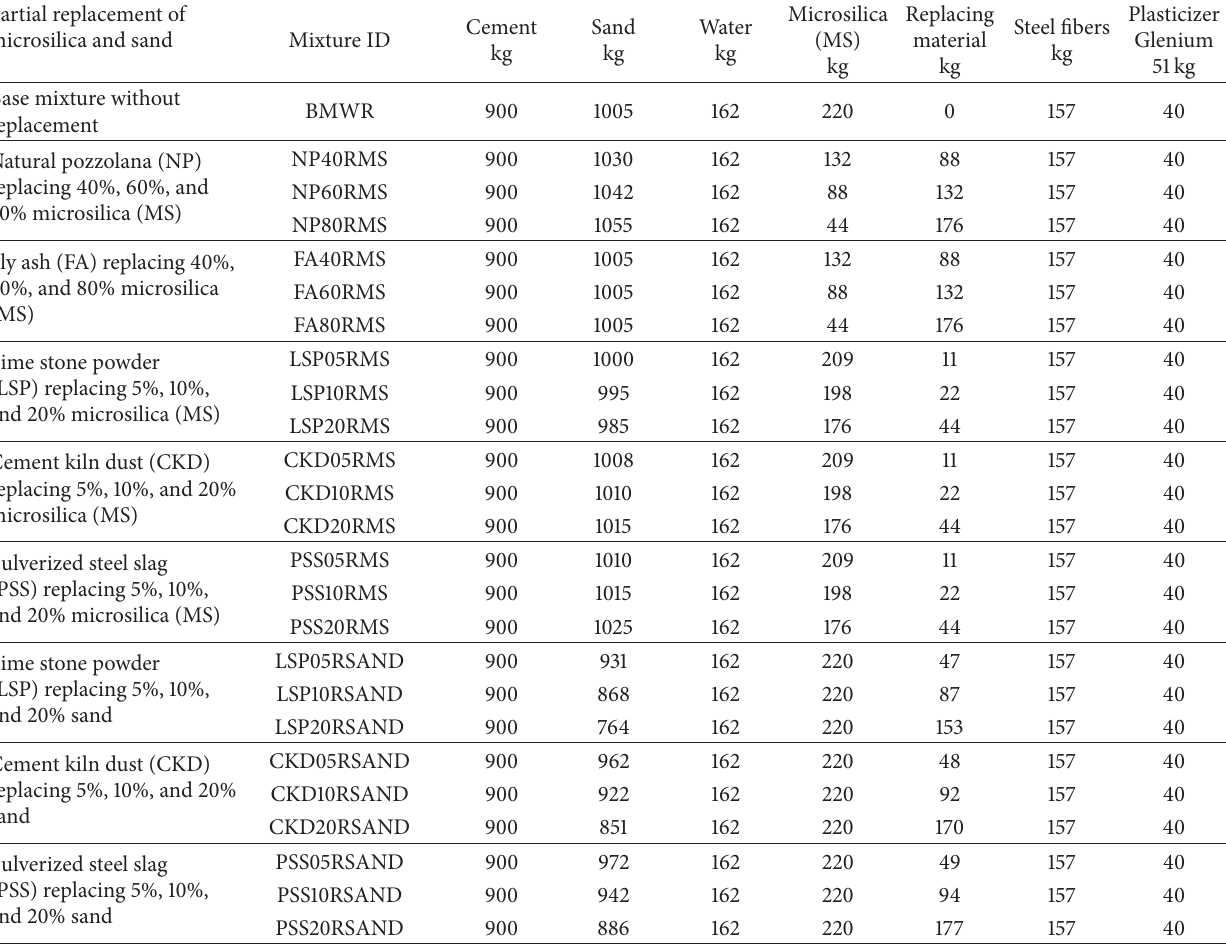
Table 7: Quantities of all ingredients for producing 1m 3 of the trial UHPC mixtures.